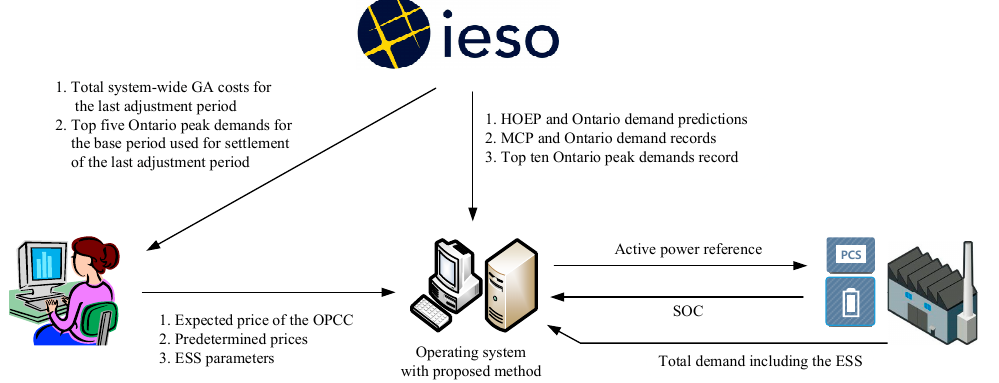
Figure 5. Flow of the major data.